Question: Reading the figure, is the described quantity rising or falling?
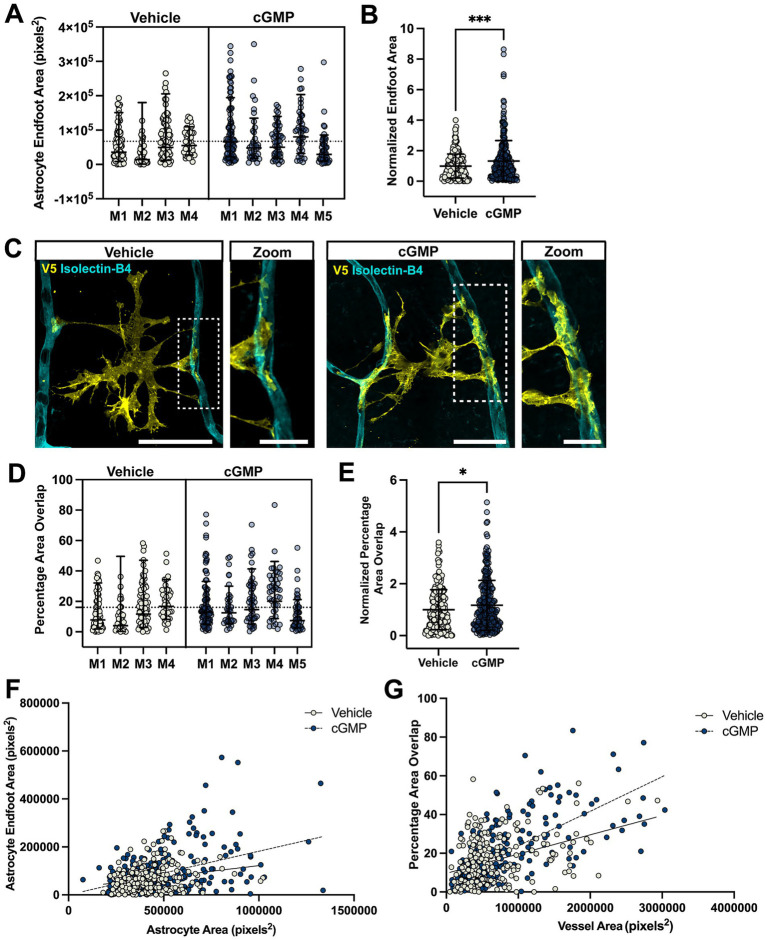
Answer: increasing